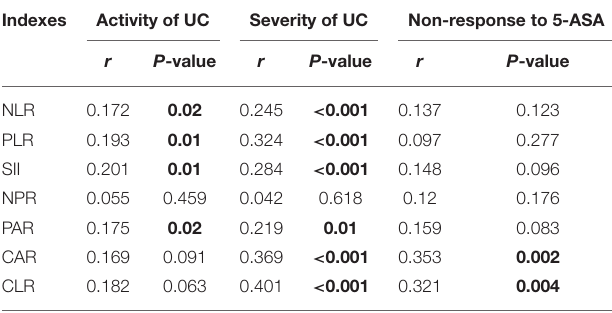
TABLE 3 | Correlation analyses of inflammatory indexes with the activity of UC, the severity of UC, and non-response to 5-aminosalicylic acid